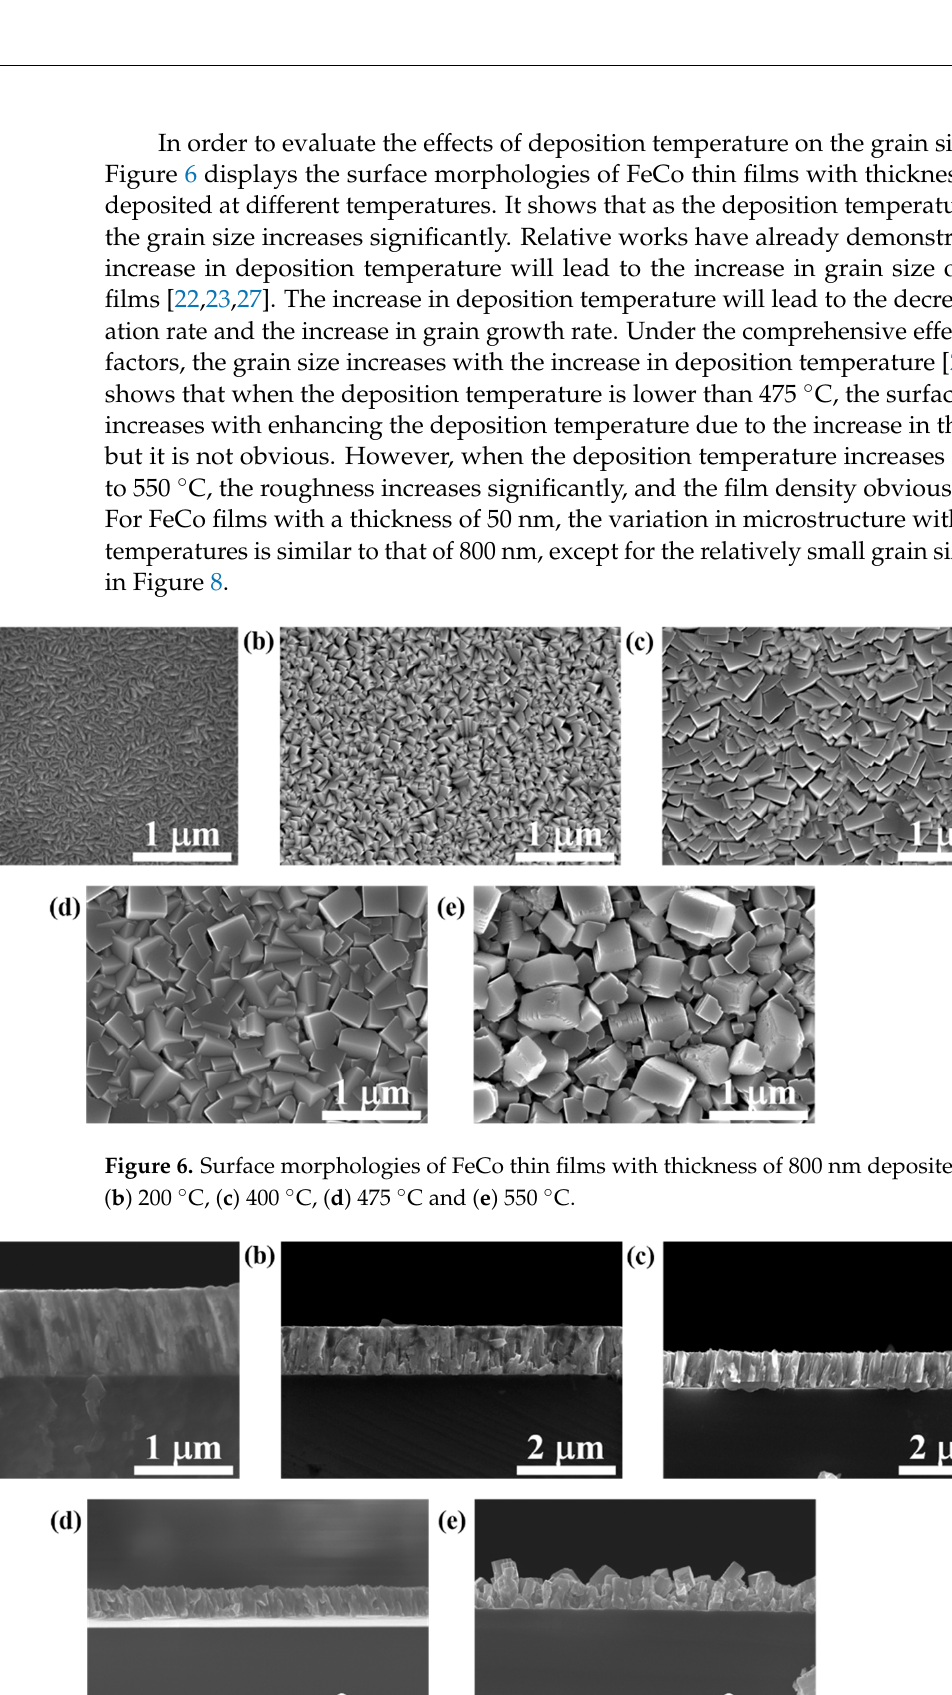
Figure 8. Surface morphologies of FeCo thin films with thickness of 50 nm deposited at ( a ) 25 °C, ( b ) 200 °C, ( c ) 400 °C, ( d ) 475 °C and ( e ) 550 °C. Figure 9 shows the variation in coercivity and saturation magnetization of FeCo films with different thicknesses. It indicates that the saturation magnetization and coercivity decrease first, and then remain stable with the increase in thickness. When the film thick- ness increases from 50 nm to 800 nm, the coercivity decreases from 309 Oe to 160 Oe, and the saturation magnetization decreases from 22.1 kG to 15.3 kG. The decrease in saturation magnetization is related to the disappearance of the (200) diffraction peak. Due to the ef- fect of demagnetization field, the effective magnetization of the film should be located in the film plane. However, in practice there is an angle between the direction of effective magnetization and the film plane for FeCo film. Compared with (110) texture, the effective magnetization of (200) texture is closer to the film plane [28]. Therefore, the films with (200) texture would have higher saturation magnetization. Previous studies revealed that reducing film stress could significantly reduce coercivity [29]. This is because the stress in the film may lead to the magnetostrictive effect, resulting in magnetic anisotropy. As the thickness increases, the stress of the film decreases, so the coercivity decreases.